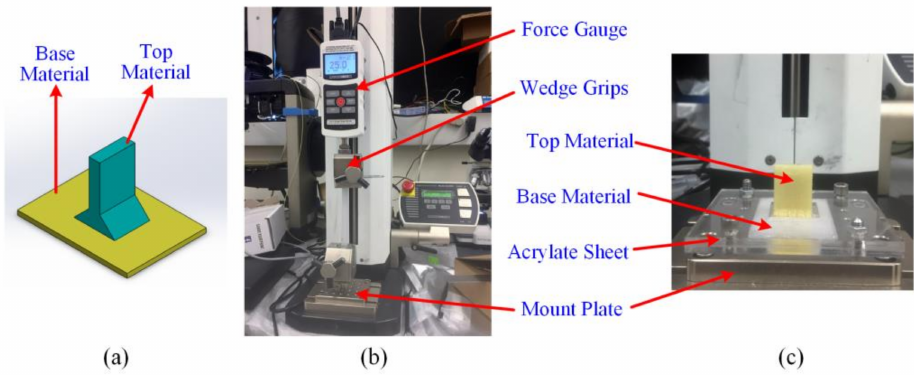
Figure 2. Experimental setup for measuring of the adhesion strength ( a ) specimen design, ( b ) overview of the experimental setup, ( c ) close-up view of the specimen being secured to the mount plate.